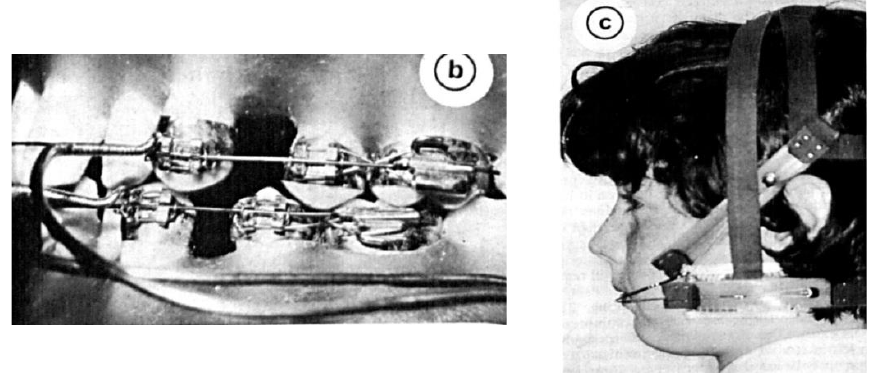
Figure (9): Canine retraction with